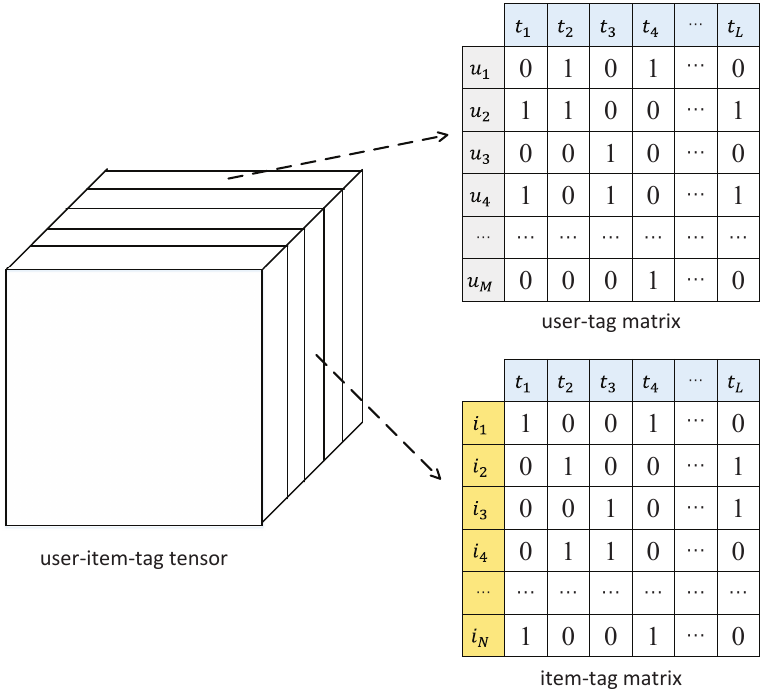
Figure 1. Illustration of decomposing the user–item–tag tensor into two adjacent matrices: user–tag matrix and item–tag